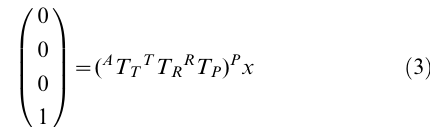
Figure S2 (a) The crosswire phantom is imaged at multiple angles by the transducer with attached 6DOF sensor. (b) The spatial location of the sensor and coordinates of the cross in the resultant image provide x p and T T R for Eq.